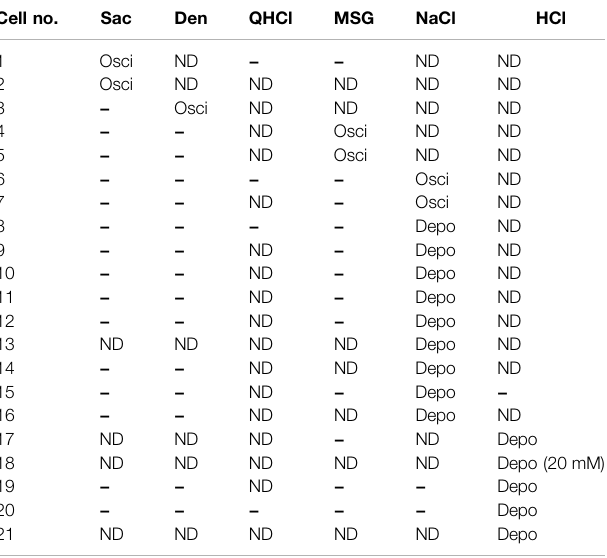
( Figure 1C , 10 mM denatonium, 1 of 67 TBCs) and umami taste substance ( Figure 1D , 500 mM MSG, 2 of 55 TBCs).